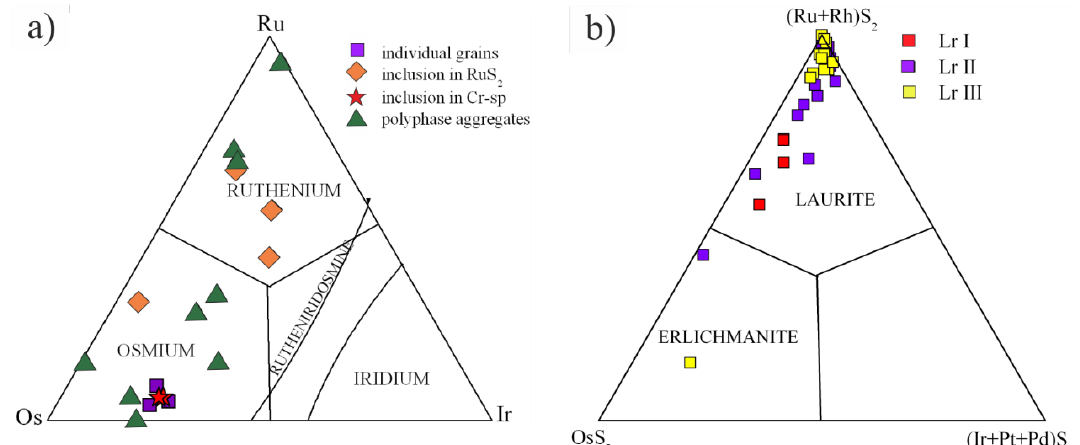
Figure 8. Diagram of the compositions of PGE minerals: ( a ) Os-Ir-Ru alloys; ( b ) Laurite-erlichmanite: Lr I—primary, inclusion in chrome spinels or isolated grains, laurite II—primary altered sulfides, and laurite III—secondary sulfides. The fields shown in the diagrams are drawn from [41].